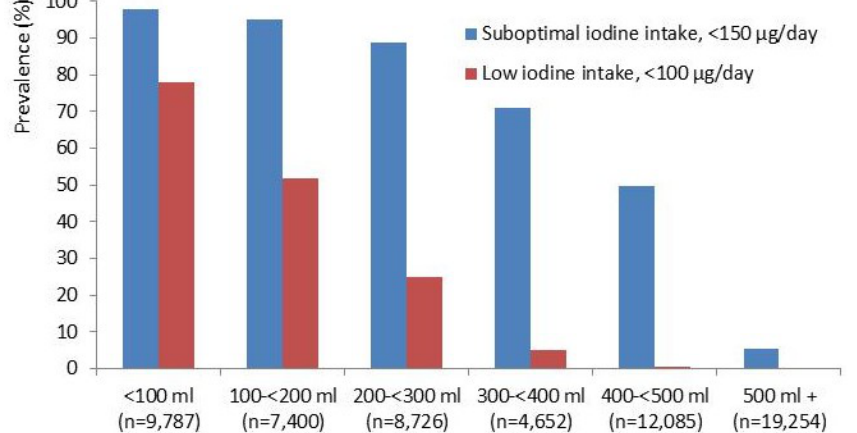
Figure 2. The prevalence of suboptimal (<150 μg/day) and low (<100 μg/day) iodine intake by increasing consumption of milk and/or yogurt in 42,329 non-iodine supplement